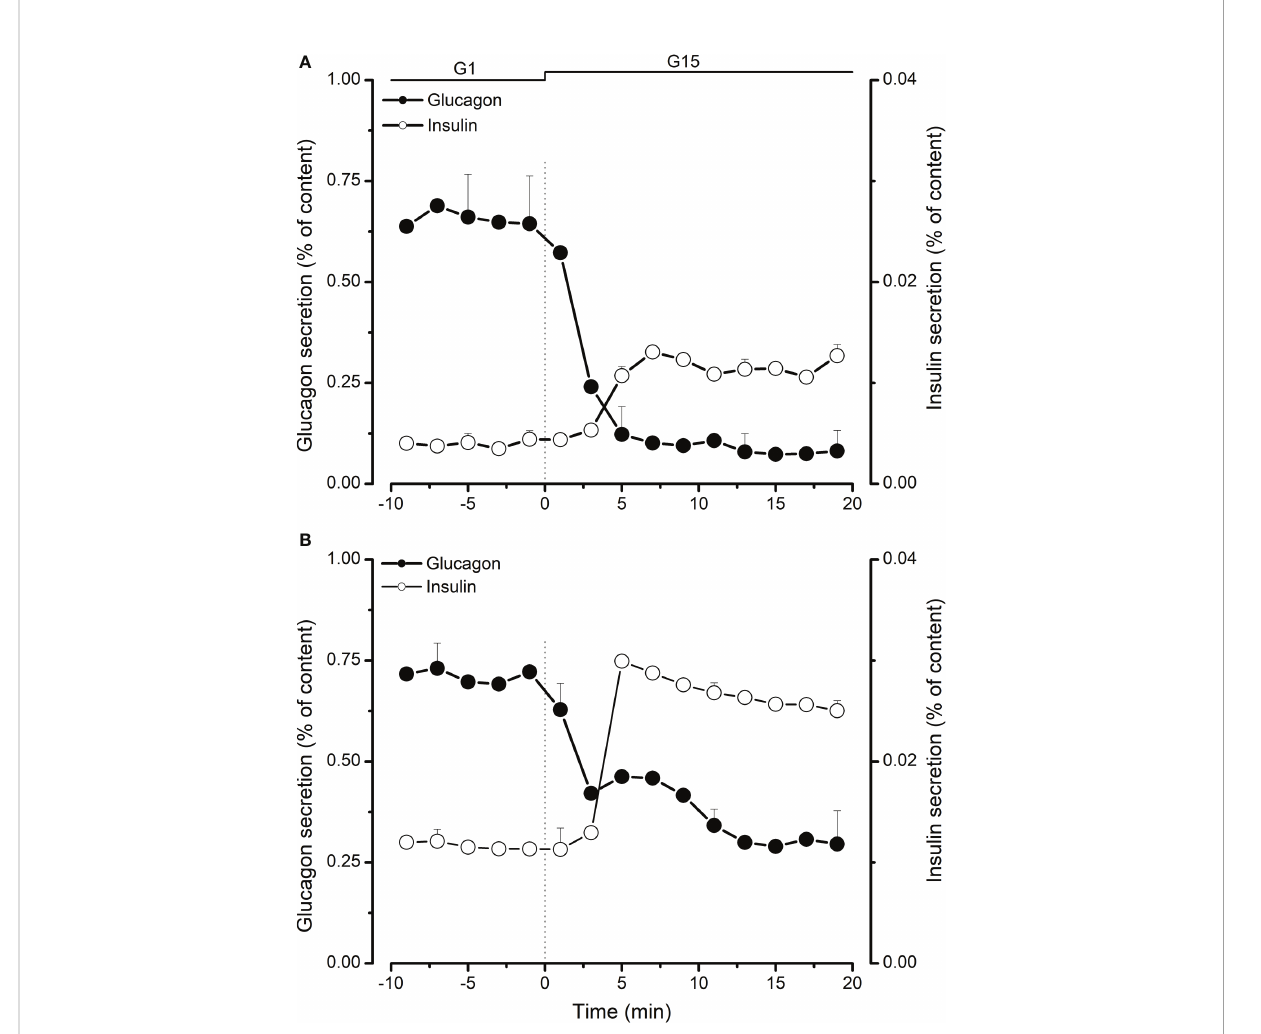
FIGURE 1 Comparison of glucagon ( ● ) and insulin ( ○ ) secretion from neonatal (A) and adult (B) perifused porcine islets. Islets in 1 mM glucose (G1) were stimulated with 15 mM glucose (G15) for 20 minutes. Glucagon and insulin secretion was measured in ef fl uent fractions and expressed as percentage of total glucagon or insulin islet content. Values are means ± SEM from n=4-8 different preparations from each age